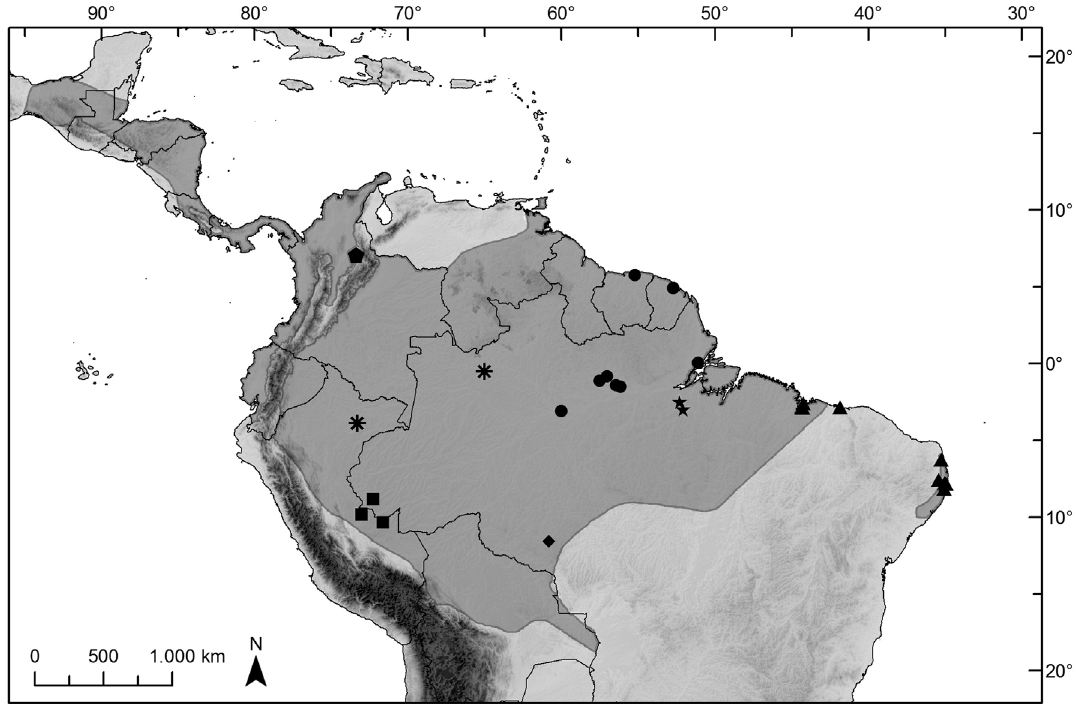
Figure 1 - Map of Cyclopes didactylus range and sampling localities. Species distribution based on Superina et al. (2010). Different symbols mark locali- ties of each geographic clusters. Square = UA; diamond = RO; asterisk = LS; star = PV; pentagon = CWA; circle = MOSF; and triangle =